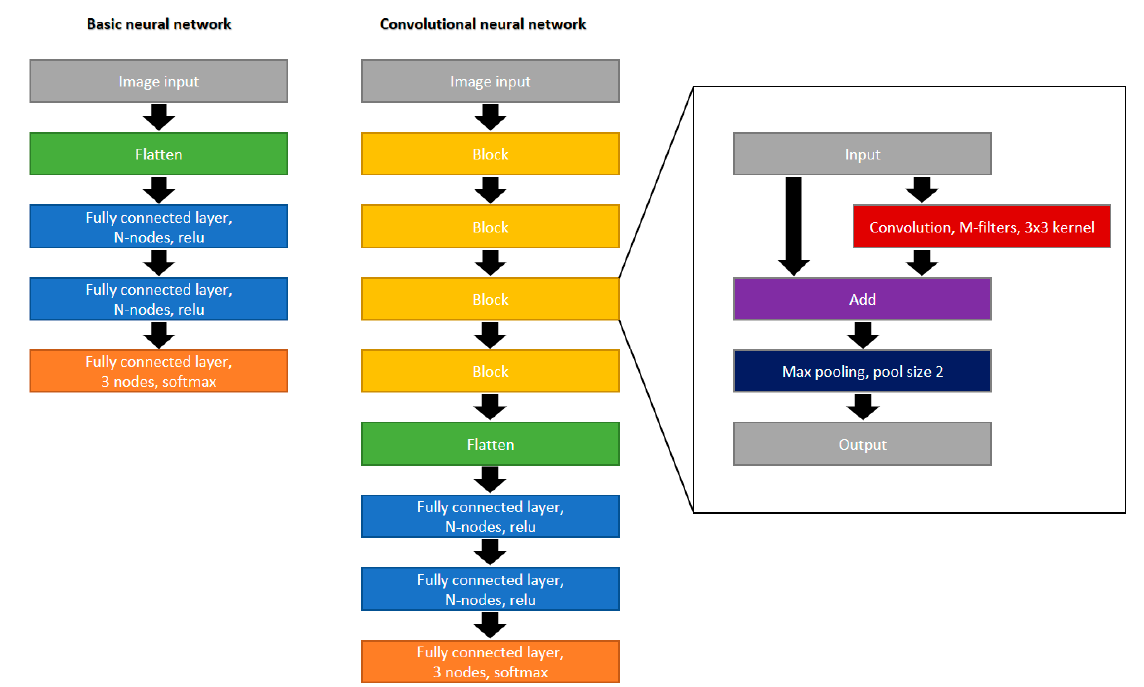
Figure 4. Design of the two neural networks.